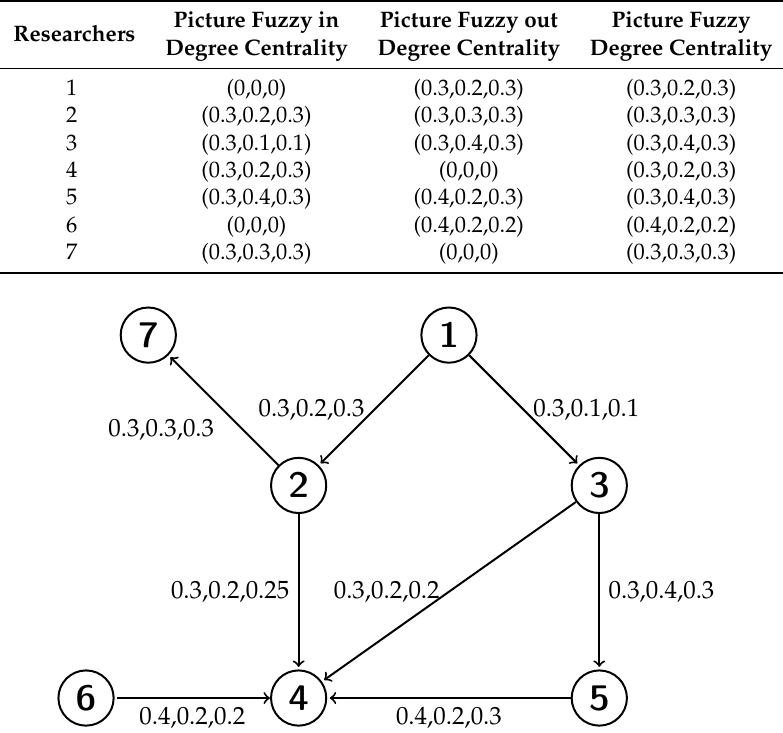
Figure 6. Directed picture fuzzy social